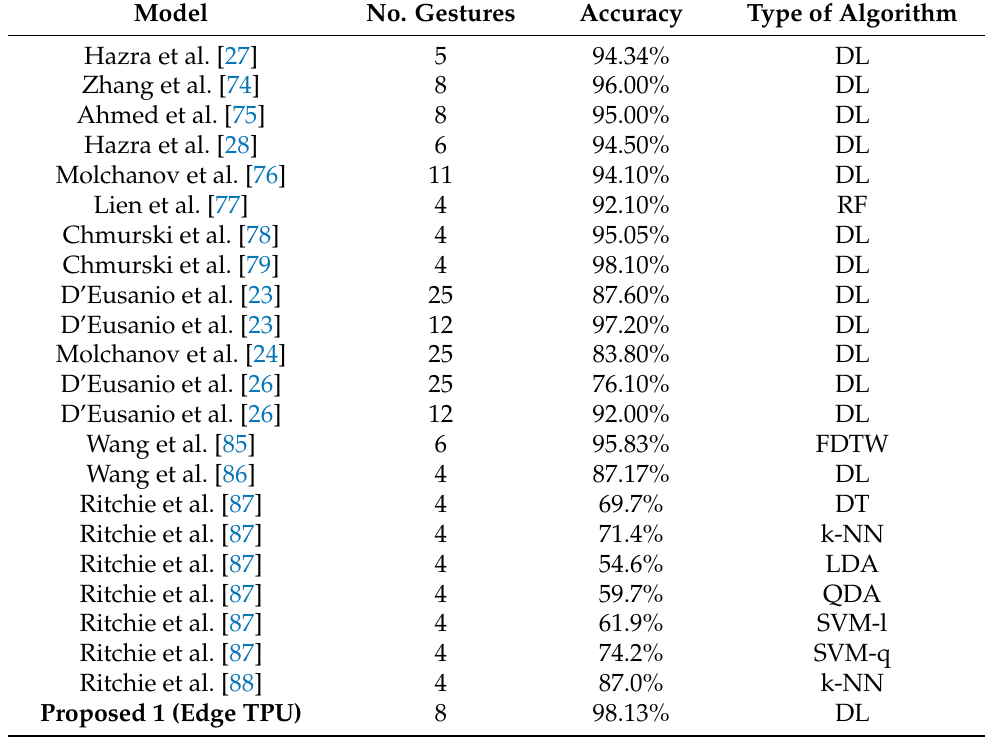
Table 2. Comparison with other approaches. DL: deep learning, k-NN: k-Nearest Neighbour, LDA: linear discriminant analysis, QDA: quadratic discriminant analysis, SVM-l: support vector machine with linear kernel, SVM-q: support vector machine with quadratic